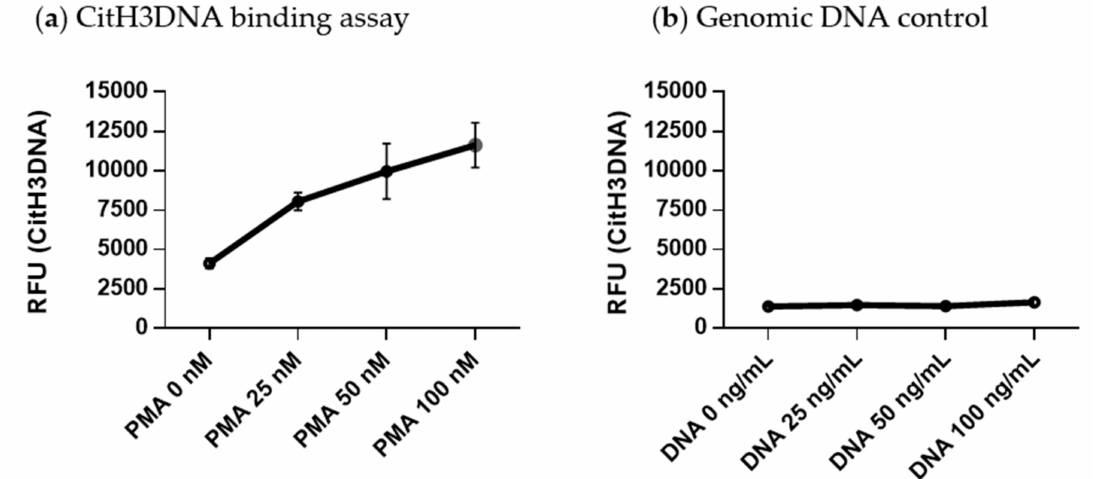
Figure 3. Quantitative citrullinated histone H3 bound to DNA (CitH3DNA) binding assay for detection of NETs. High binding 96-well plates were coated with anti-histone H3cit antibodies. ( a ) Neutrophils were isolated from BM of myeloma-bearing mice and stimulated in vitro with indicated concentrations of PMA for 4 h. NET fractions were collected from each condition and 100 µ L were loaded per well. ( b ) Indicated amount of genomic DNA was added per well. ( a , b ) Fluorescence of SYTOX Green nucleic acid stain was measured using a Victor X3 plate reader. RFU—relative fluorescence